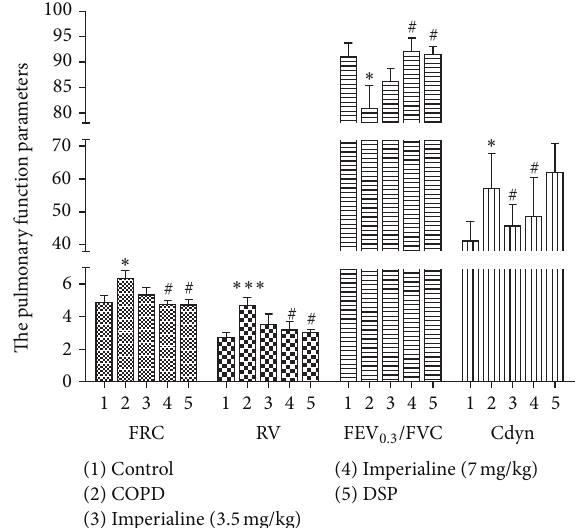
Figure 2: The pulmonary function parameters of rats in different groups. The reported values are the means ± SEM. Significant differencescomparedtothecontrolgroupareindicatedby ∗ 𝑃 < 0.05 and ∗∗∗ 𝑃 < 0.001 . Significant difference compared to the COPD model group is indicated by # 𝑃 < 0.05